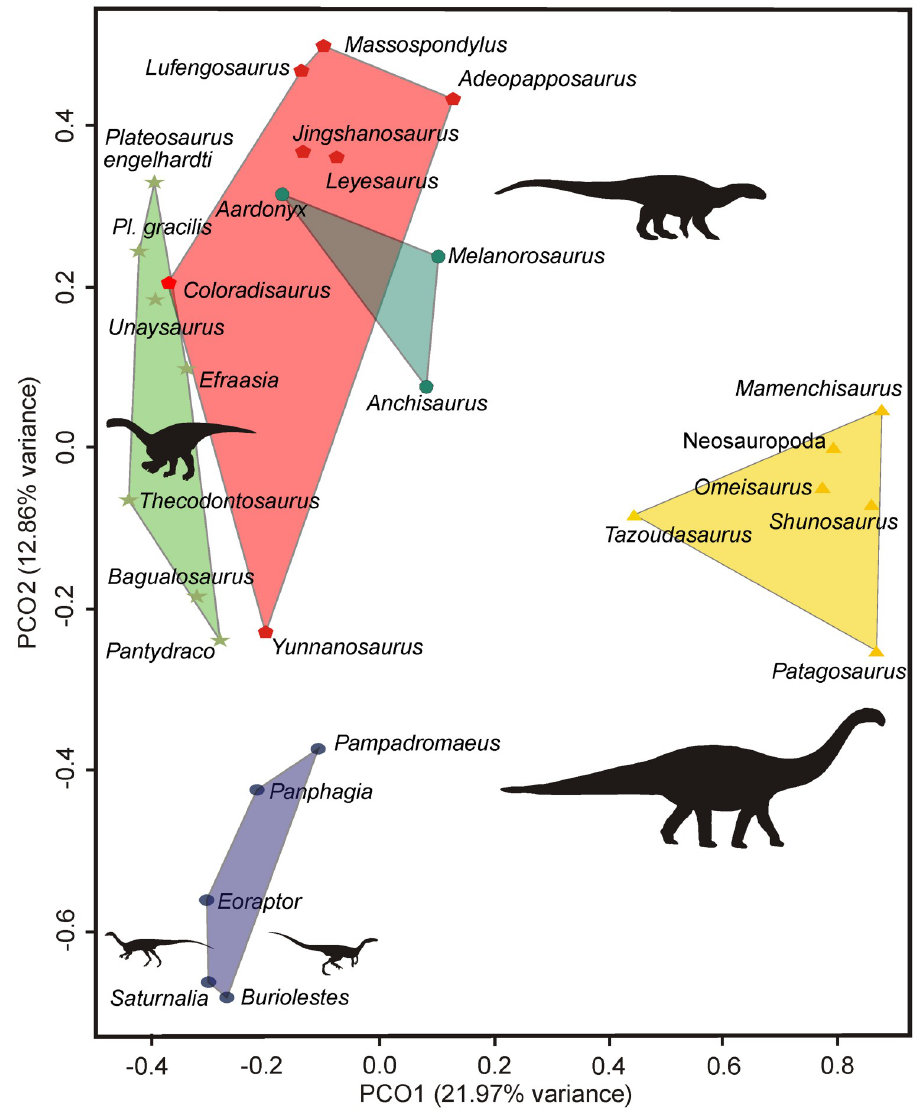
Fig 14. Results of the principal coordinate analysis based on cranial characters associated with the jaw feeding apparatus of sauropodomorphs with the variation in PCo1 plotted against PCo2. Circles, stars, pentagons, octagons, and, triangles, are assigned to the following subset of taxa, respectively: sauropodomorphs more closely related to Saturnalia tupiniquim than to Bagualosaurus agudoensis ; non-massopodan sauropodomorphs (except those represented by circles); non-anchisaurian massopodans; non-sauropodan anchisaurians; sauropods.